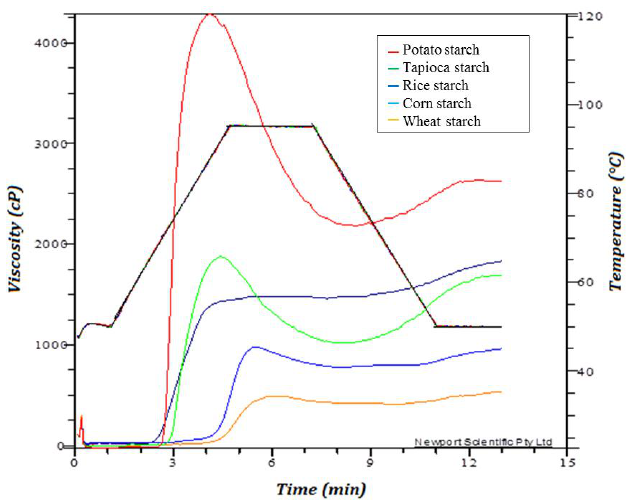
Figure 3. Pasting profiles of the different starches: Potato starch, tapioca starch, rice starch, corn starch and wheat starch.